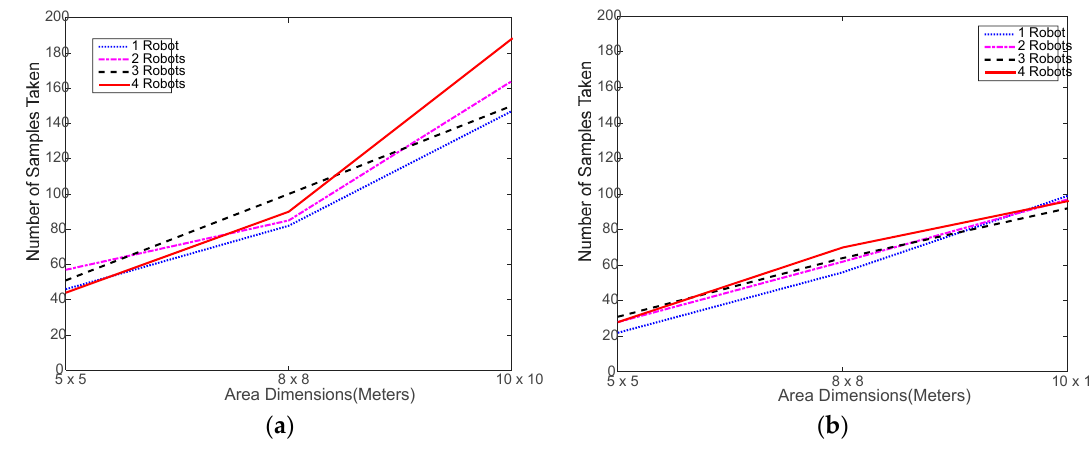
Figure 5. Number of samples collected in the experimental testing: ( a ) using distributed WiMAP algorithm; ( b ) using distributed DWiMAP.